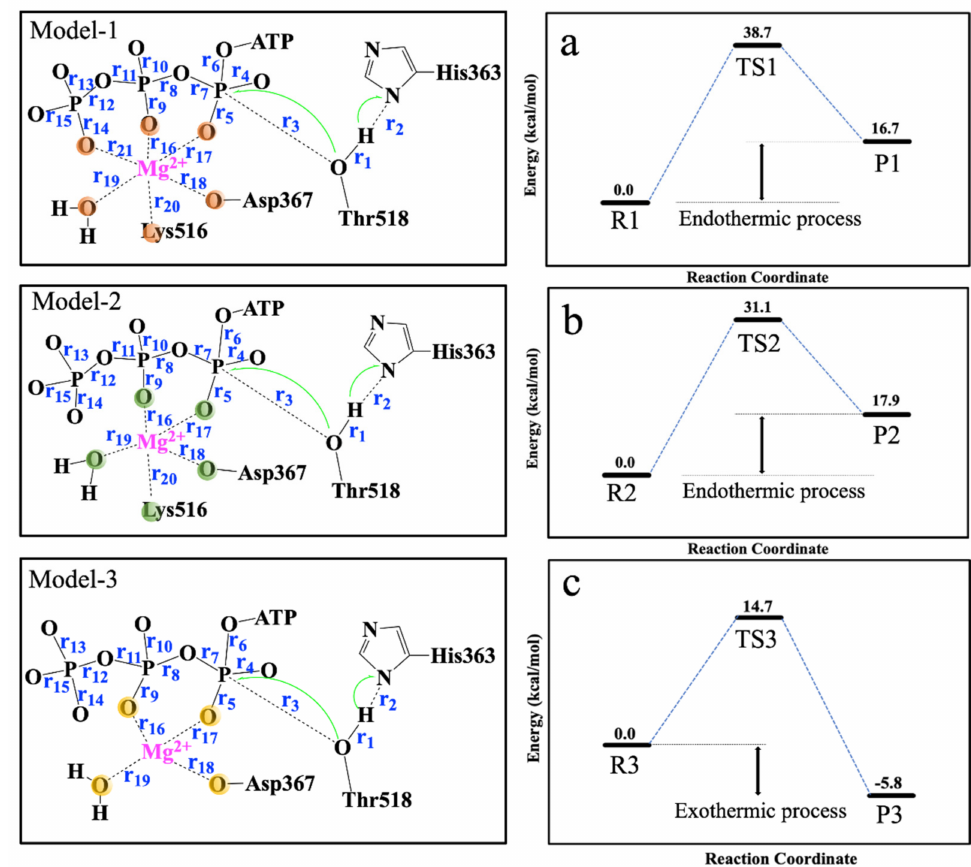
Figure 1. Free energy profiles along with the representative structures of the reactant (R), transition state (TS) and product (P) of AMPylation for the HYPE protein complexed with the BiP protein. ( a ) 6-coordinated, ( b ) 5-coordinated, ( c ) 4-coordianted. For clarity, the coordination details of Mg 2+ are shown (Model-1, Model-2 and